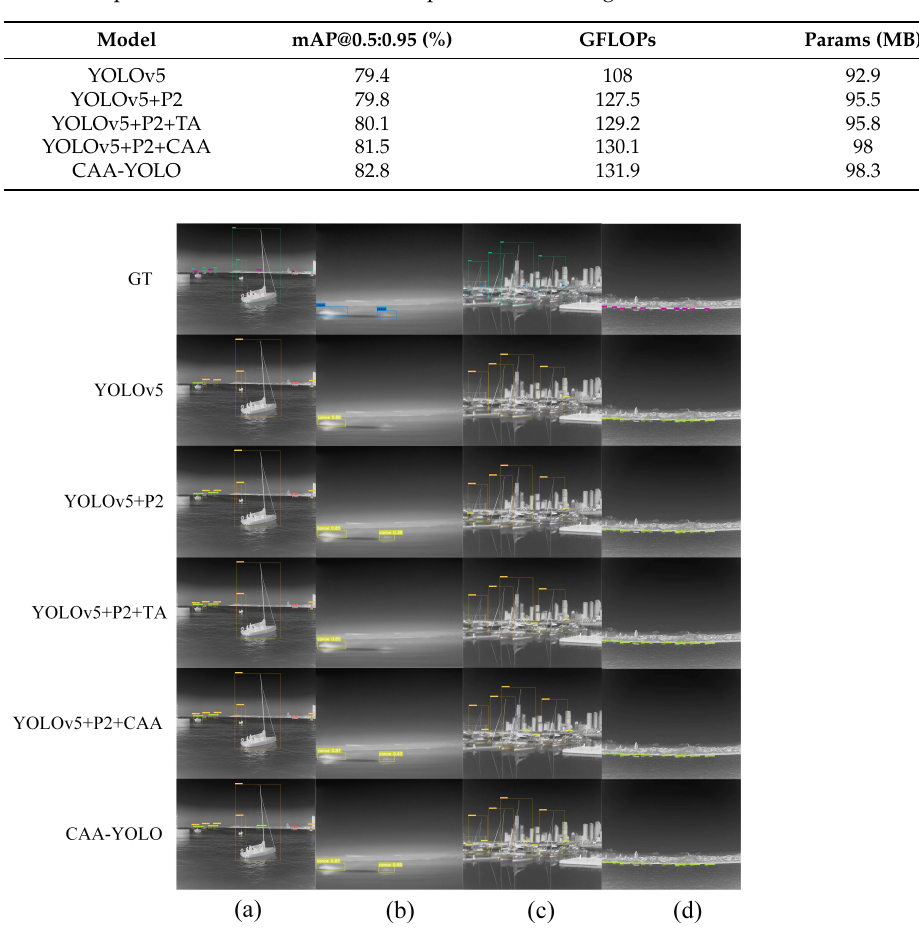
Figure 13. The infrared ship detection results of different methods. GT represents the ground